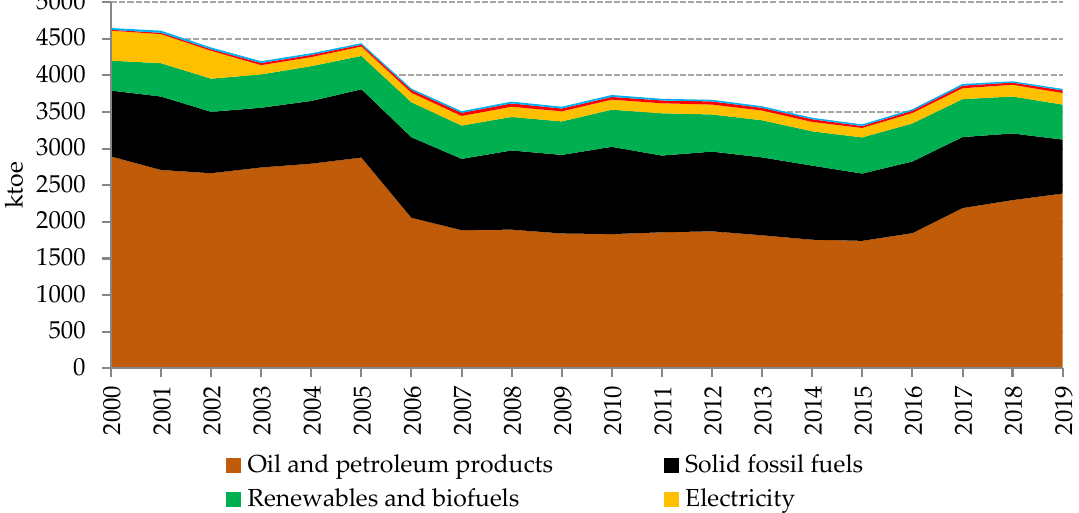
Figure 1. Energy consumption in Polish agriculture in 2000 – 2019 (ktoe).